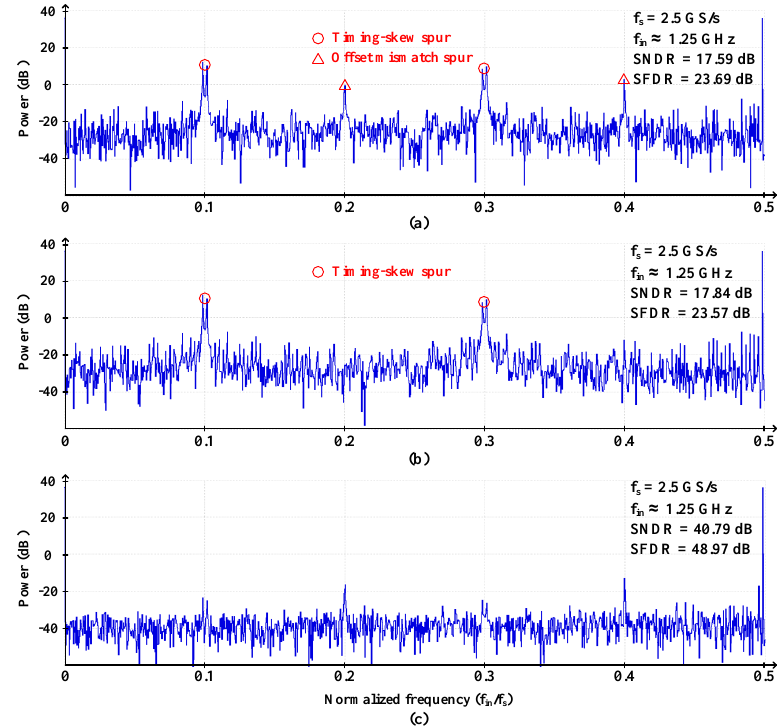
Figure 20. Fast Fourier transform (FFT) analysis of a sinusoidal input signal at Nyquist frequency ( a ) without calibration, ( b ) with offset calibration only, and ( c ) with both offset and timing-skew calibration (4096 points for FFT).